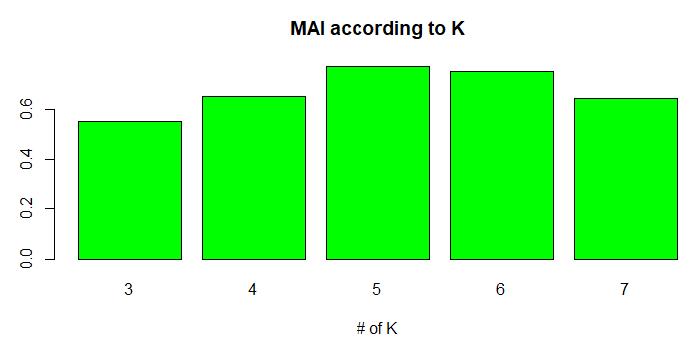
Figure 8. Mean accuracy index ( MAI ) of FWS according to K (bin width = 0.2).